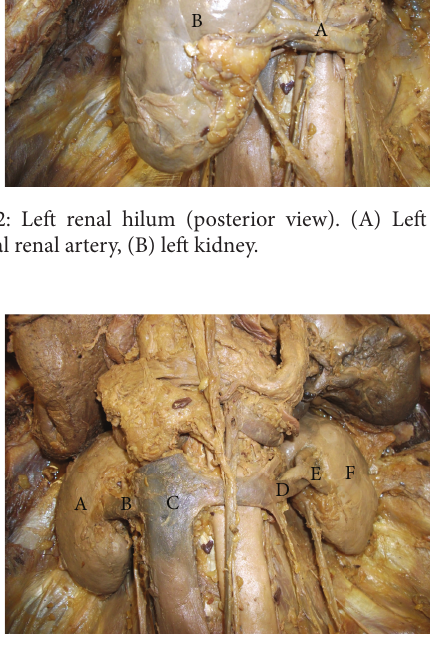
Figure 3: Right and left renal hila (anterior view). (A) Right kidney, (B) right renal vein, (C) inferior vena cava, (D) left renal vein, (E) left anterior inferior segmental renal artery, and (F) left